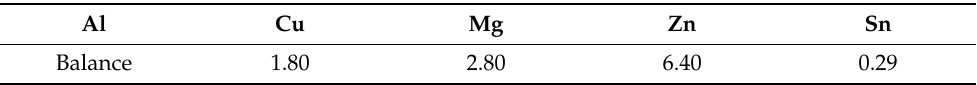
Table 1. Chemical composition of Alumix 431 powder delivered by ECKA Granules Germany GmbH (wt%). Al Cu Mg Zn Sn Balance 1.80 2.80 6.40